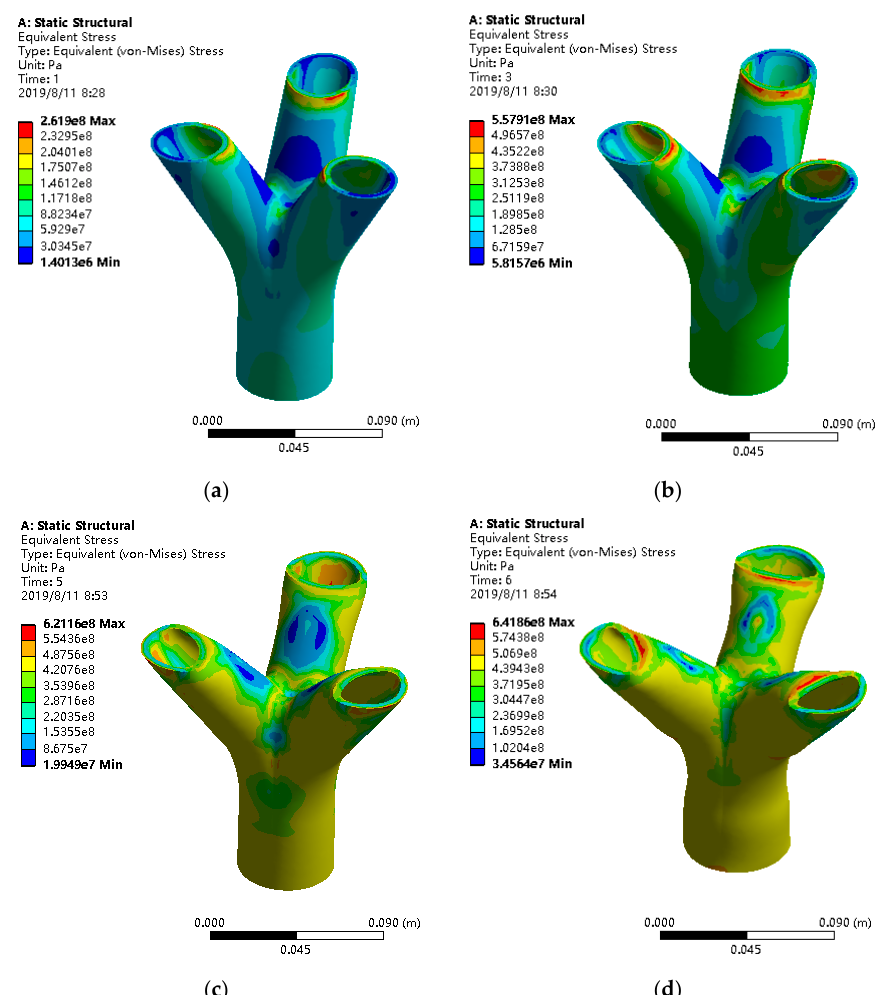
Figure 17. Stress cloud diagram of joints under different loads: ( a ) When the load is 100 kN; ( b ) When the load is 200 kN; ( c ) When the load is 300 kN; ( d ) When the load reaches the maximum load.